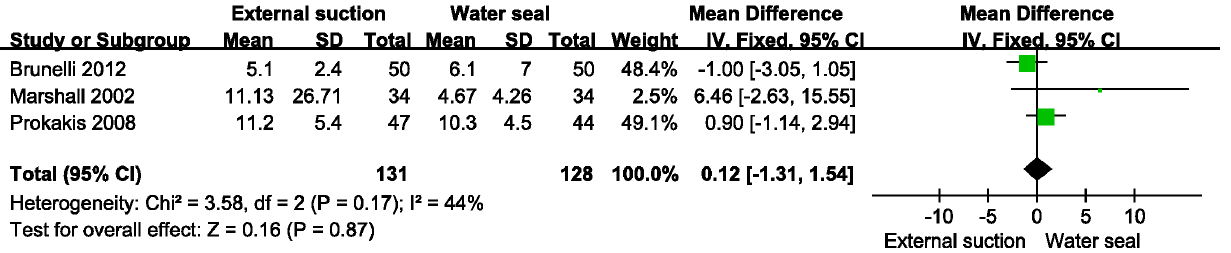
Figure 5. Meta-analysis of external suction versus water seal on the postoperative hospital stay. IV, inverse variance method.